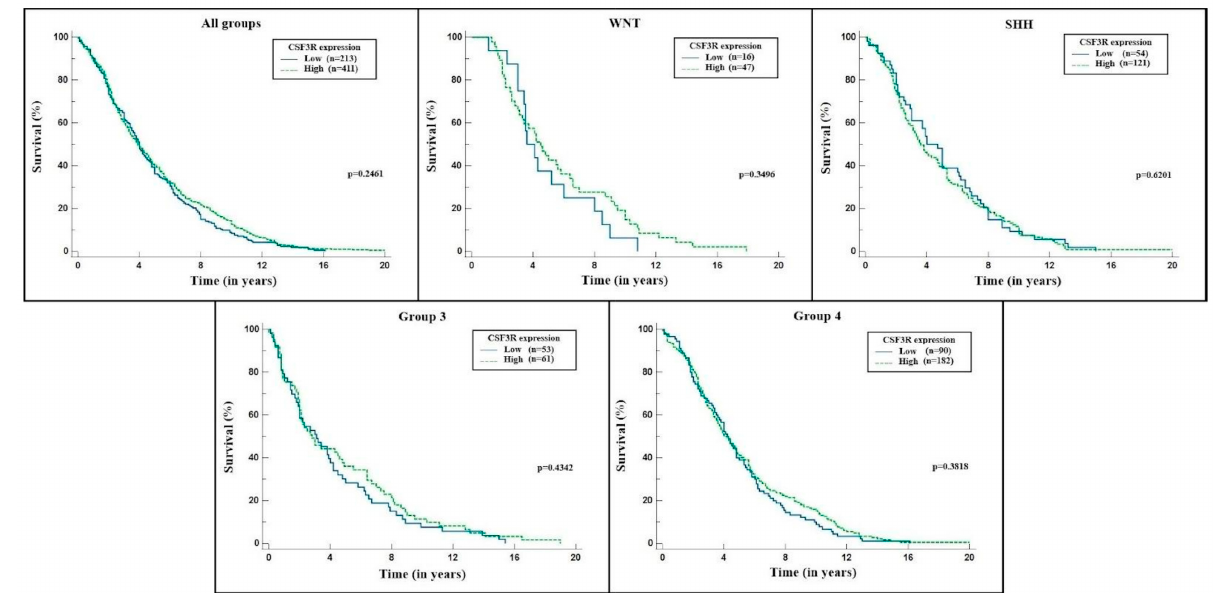
Figure 5. CSF3R expression × survival (25th percentile) for each molecular group and total sample. Source: the authors. Compiled using MedCalc ® version 20.115 (MedCalc Software Ltd., Ostend, Belgium).